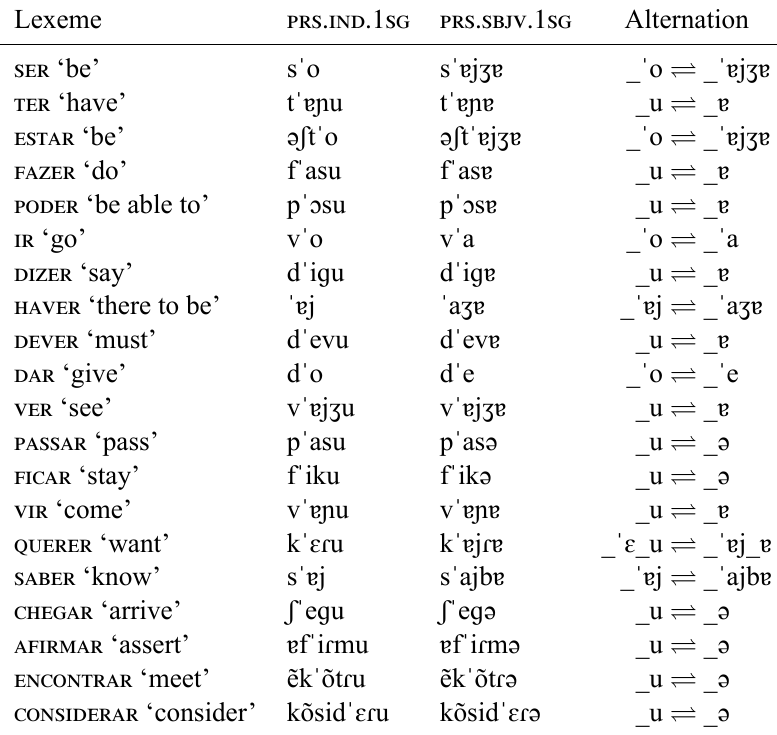
Table 4: Basic alternations relating the PRS.IND.1SG to the PRS.SBJV.1SG for the 20 most frequent verbs in the